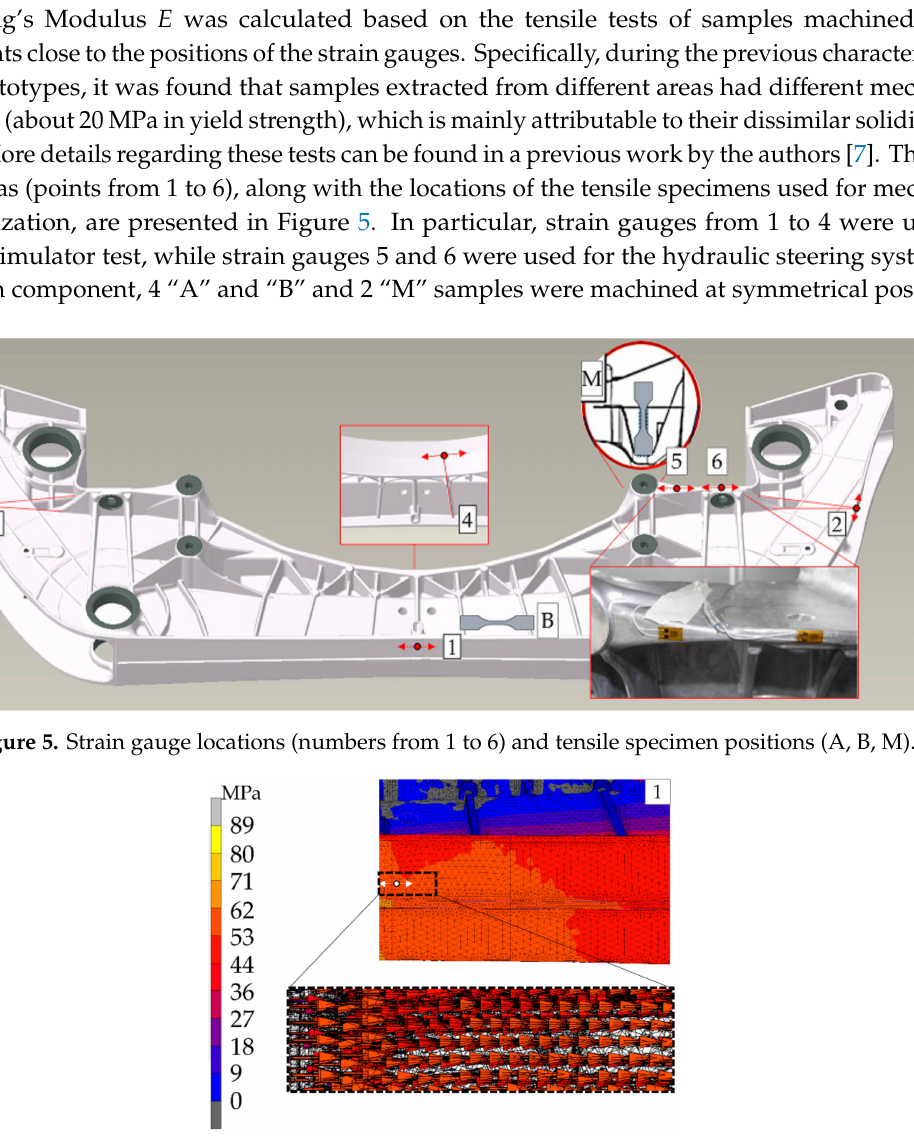
Figure 6. Strain gauge number 1 orientation based on principal stress vector plot of vertical load